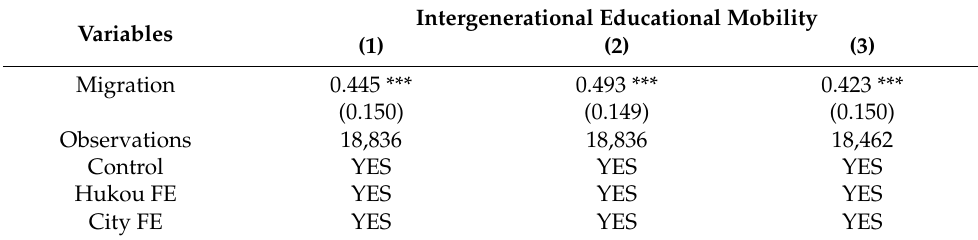
Table 7. Other threats to